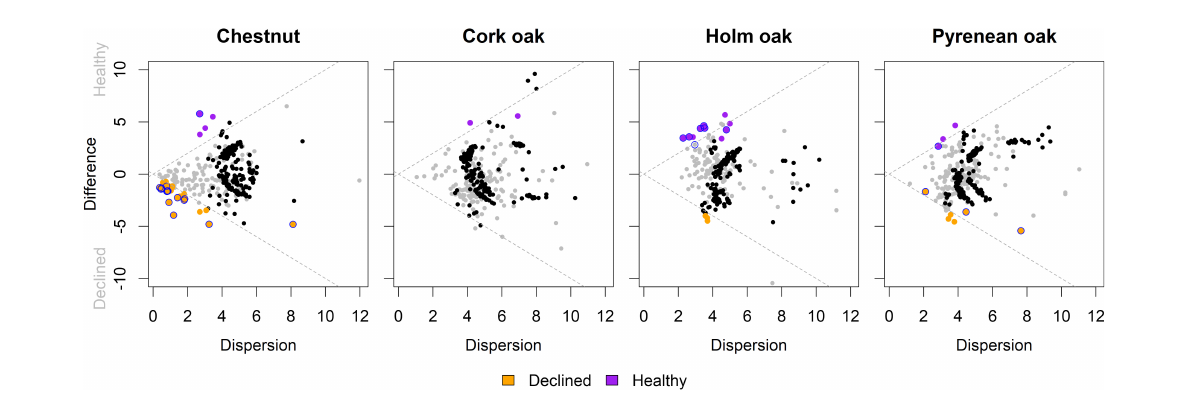
FIGURE6 Effect plot of ALDEx differential abundance comparisons. Colored dots represent genera with effect size > 1 (purple if more abundant in samples from healthy trees and orange if more abundant in samples from declined trees); blue outline indicates differential abundance (zero not included in 95% CI); rare (clr-transformed abundance < 0) non significant genera are shown in black and abundant (clr-transformed abundance > 0) in grey, as represented in the Bland–Altmann plots in Supplementary Figure 4 . Dotted gray lines show the effect = 1 isopleth. Vertical and horizontal axes represent Median Log 2 transformations of abundances’ difference (between samples variability) and dispersion (within samples variability), respectively.